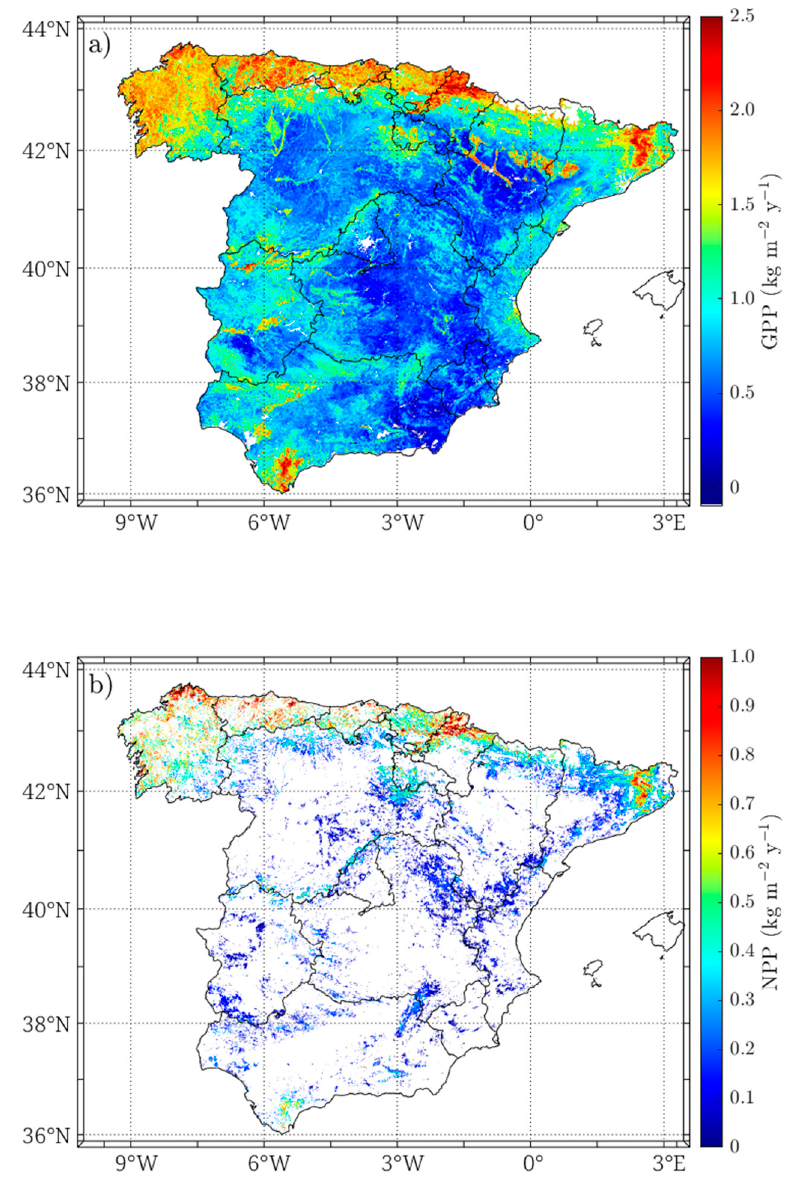
Figure 3. Average annual GPP ( a ) and NPP ( b ) for the period 2004–2018.